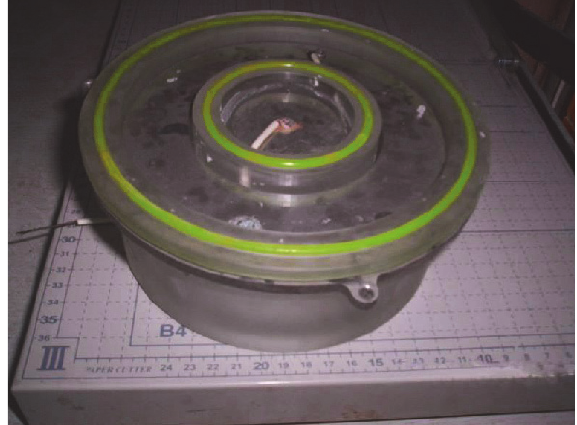
Figure 3: Prototype of the AC impedance field testing.